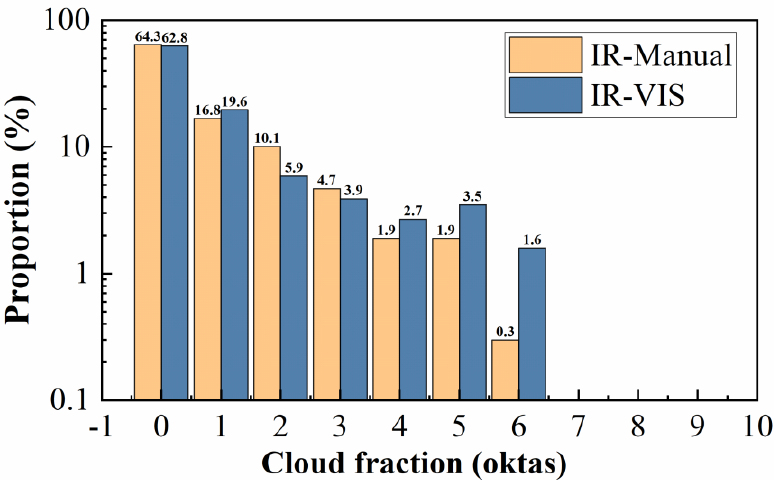
Figure 9. Distribution of cloud fraction difference between the infrared and visible (IR-VIS), and the infrared and manual observations (IR-Manual). infrared and manual observations